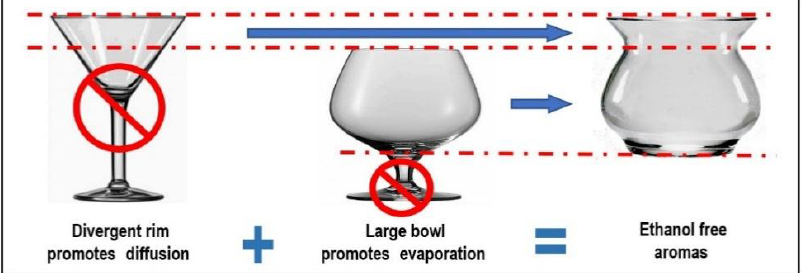
Figure 4. Small convergent rims contribute to ethanol anesthesia. Note “cloud” shapes over vessel rims. Extensive experimentation by Mitsubayashi et al. [16], using an infrared “sniffer-camera” to photograph ethanol cloud shapes created by different vessel shapes through a catalytic coated mesh validates the ethanol evaporation patterns shown. Prior to Mitsubayashi, cloud shapes could not be imaged, since infrared does not detect ethanol. Previous cloud “boundaries” were empirically determined by careful nosing.